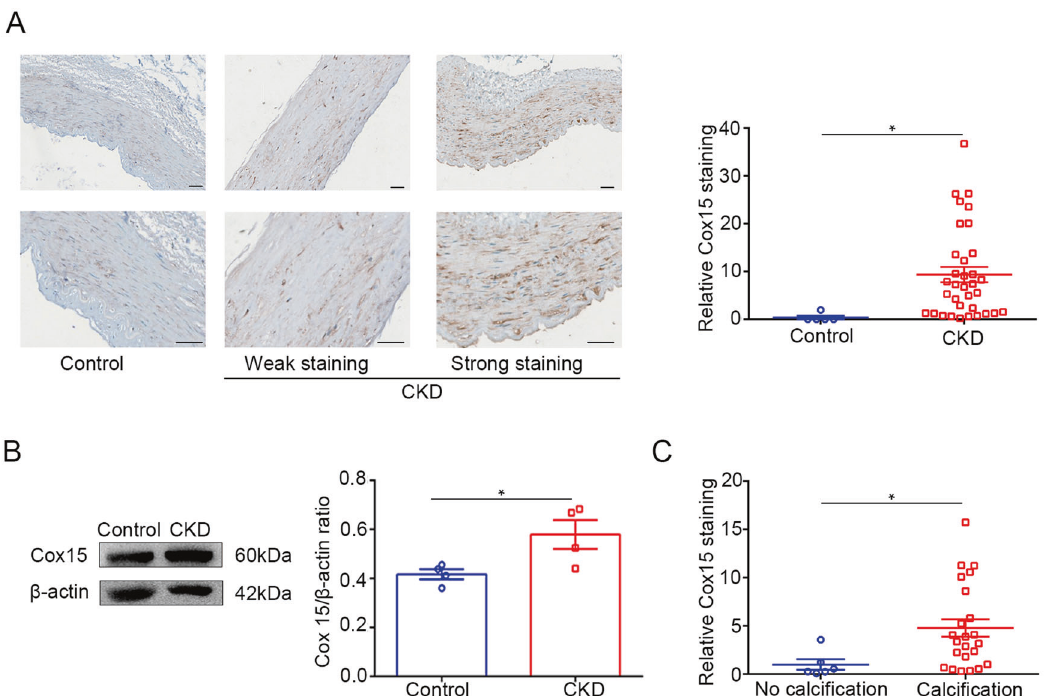
Fig. 7 The expression of Cox15 is enhanced in the artery of patients with CKD. A Representative images and quanti fi cation of immunohistochemistry staining of COX15 in arteries of patients with or without CKD (unpaired t test; Control n = 5, CKD n = 34). B Western blot and its quanti fi cation analysis in arteries of patients with or without CKD (unpaired t test; n = 4). C Comparison of the intensity of COX15 expression in CKD patients with aortic arch calci fi cation and those without aortic arch calci fi cation (unpaired t test; no calci fi cation n = 6, calci fi cation n = 23). * P < 0.05. Scale bar = 50